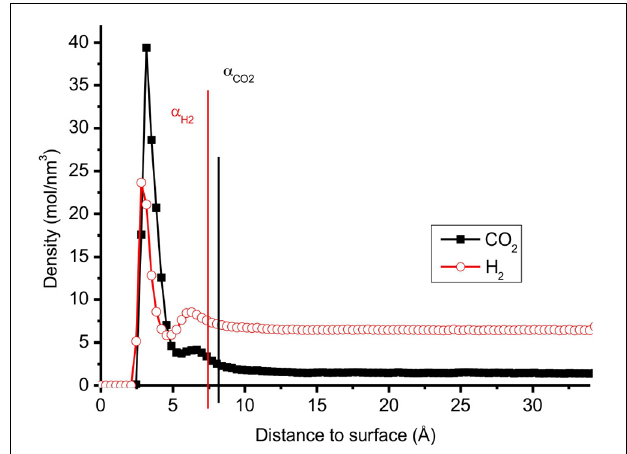
FIGURE 4 | The distribution of pure CO 2 and pure H 2 molecules perpendicular to the surface in a mixture with N = 700 at temperature T = 300K. One can distinguish two regions for each molecule; 0- α : adsorbed layer, above α : gas phase.